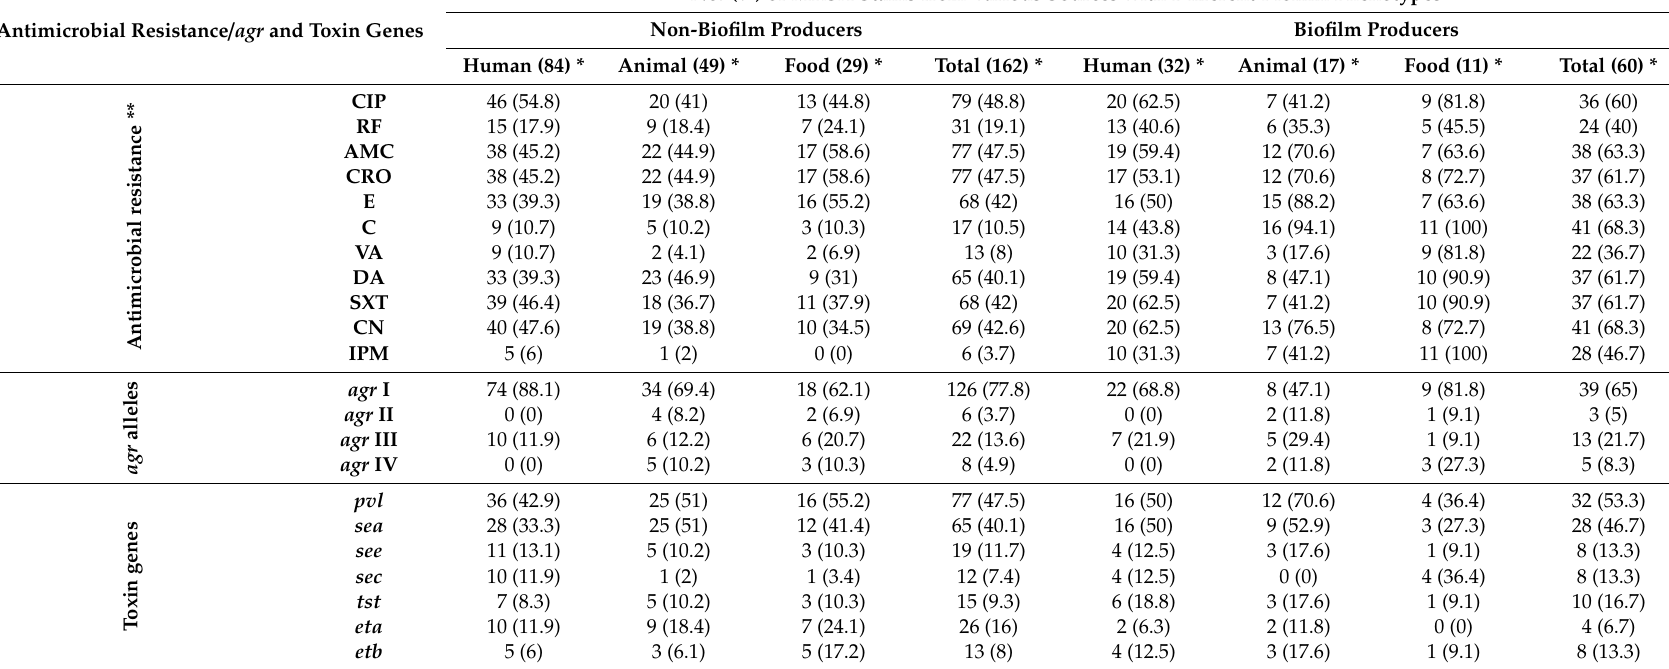
Table 1. Detailed characteristics of biofilm and non-biofilm producing methicillin-resistant Staphylococcus aureus isolates from di ff erent sources regarding antimicrobial resistance and agr and toxin